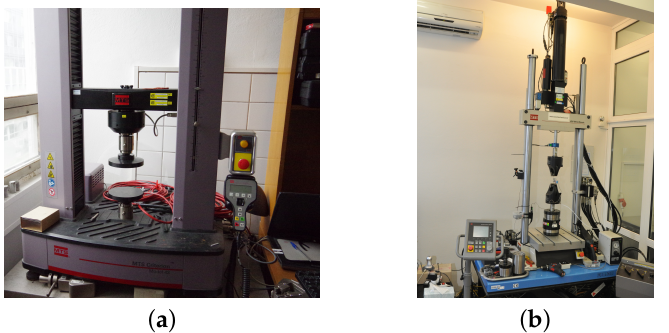
Figure 5. ( a ) MTS Alliance 30 kN electromechanical testing system, ( b ) MTS Mini Bionix 858.02 testing